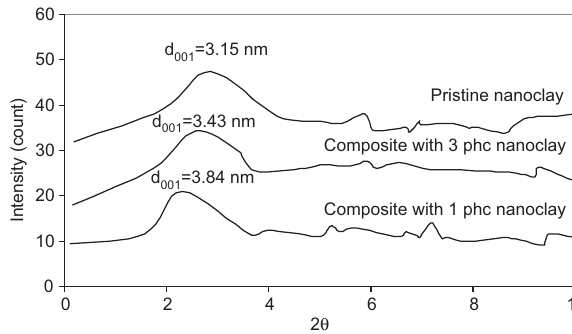
Figure 3 X-ray scattering intensities for PP/hemp fiber composites with different levels of